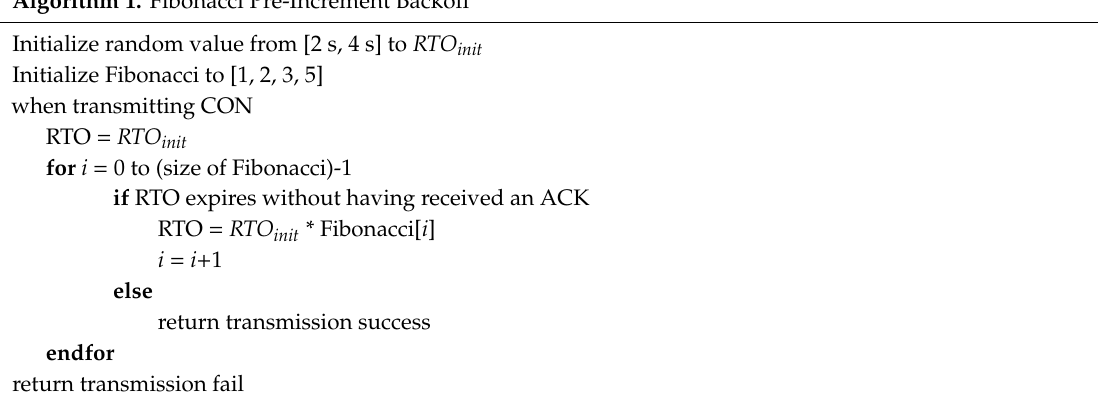
Algorithm 1. Fibonacci Pre-Increment Backo